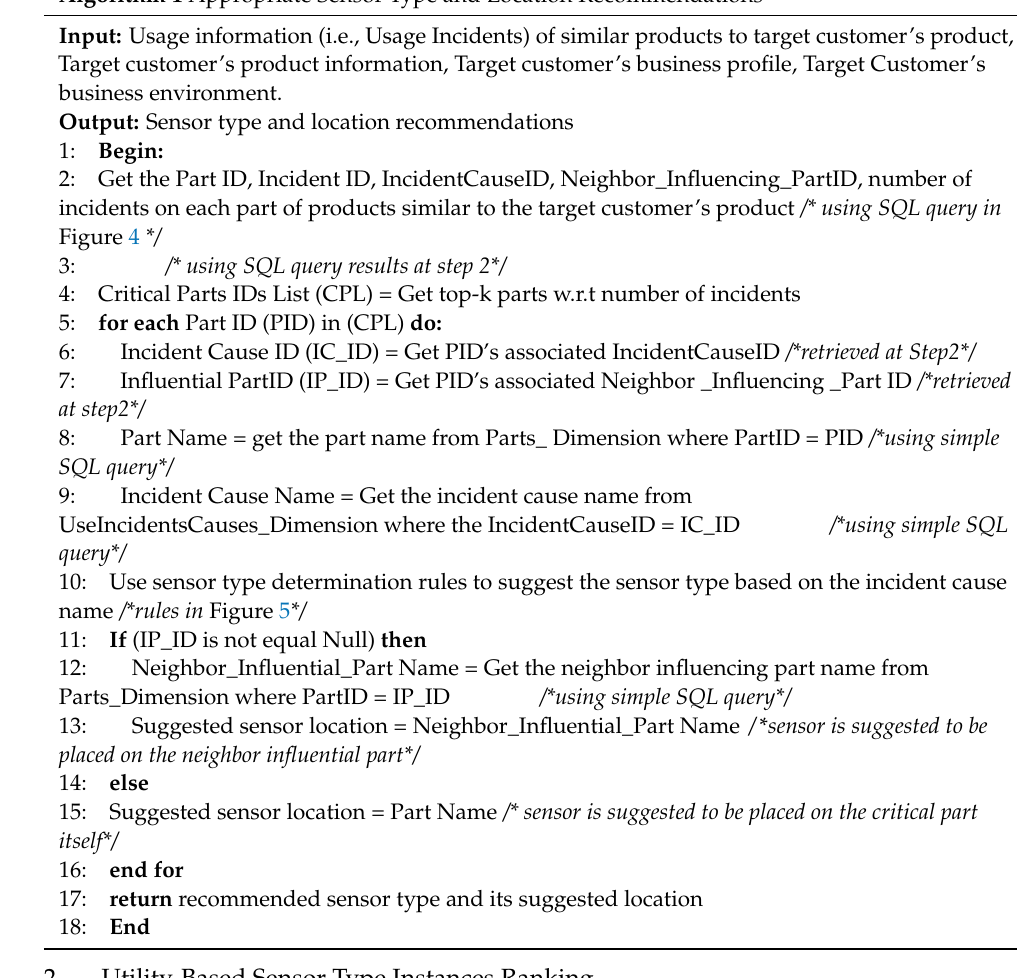
Algorithm 1 Appropriate Sensor Type and Location